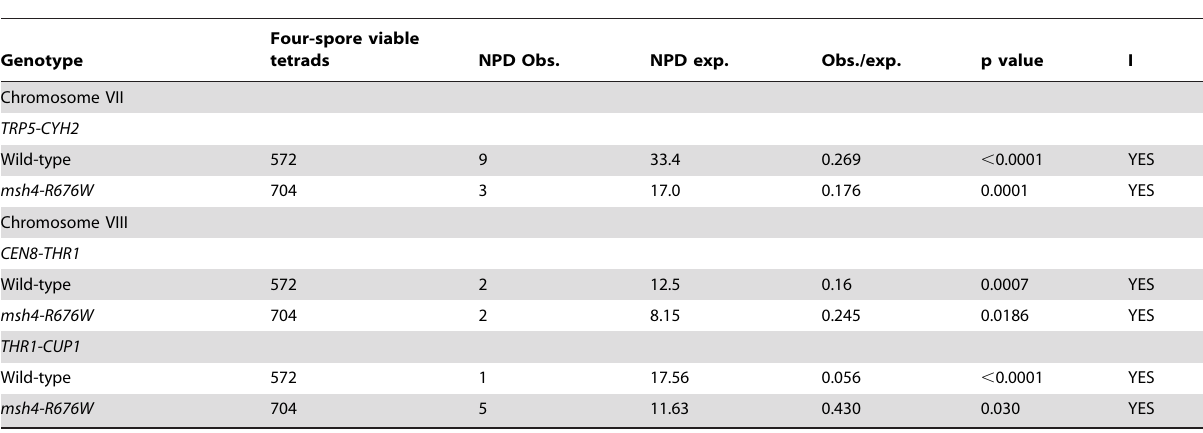
Table 5. Analysis of crossover interference in msh4-R676W by the NPD ratio.